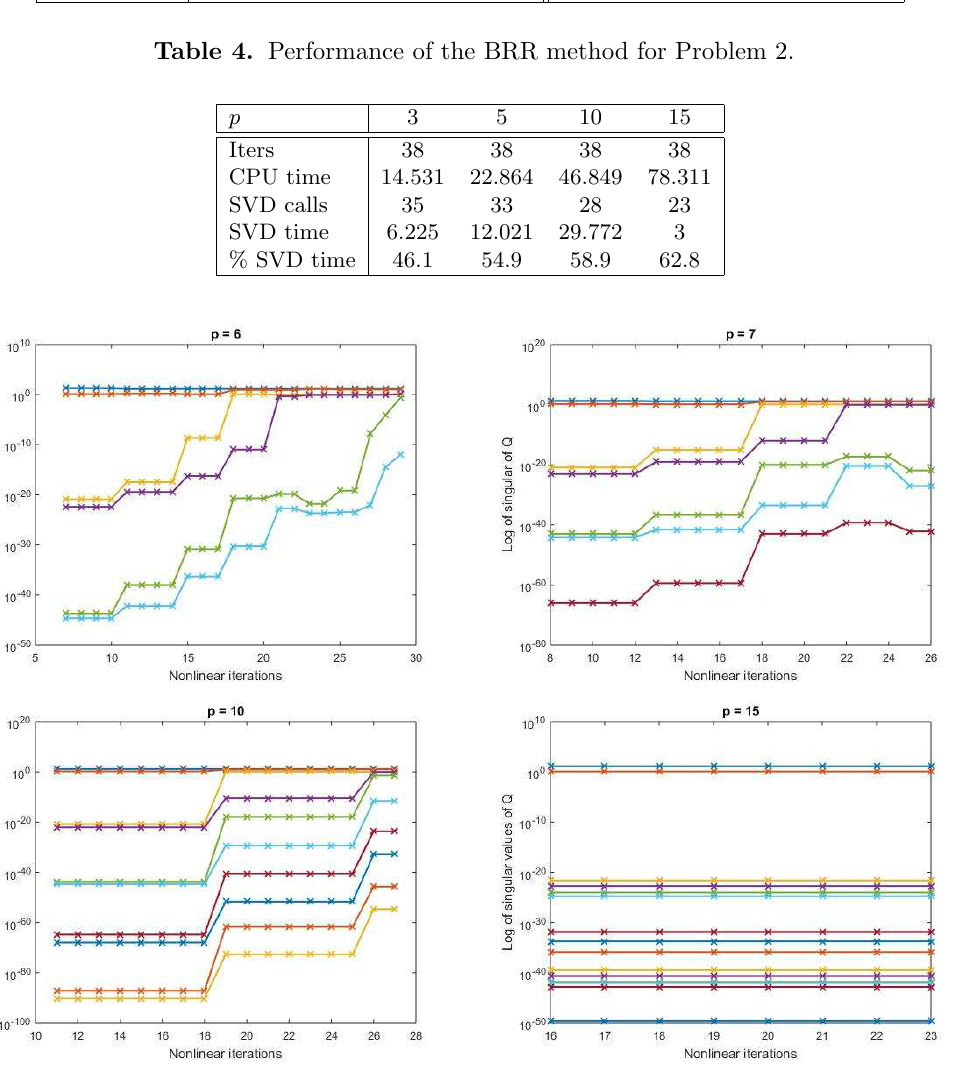
Figure 3. Singular values of the update matrix Q for p = 6, 7, 10 and p = 15 for Problem 3. We set C = 20 and u 0 = 0. Equation (18) is For p 5 the rank of Q is p , and only the p th ≤ discretized on a 500 500 grid using centered singular value is removed. In this case, BRR and × differences. Evolution of the sigular values of Q DBRR methods behave similarly, see tables 7 and 8. For p = 10 the rank of Q is ten but condition is displayed in figure 4 for different values of p . (8) is satisfied in the first iterations for ε = 10 −